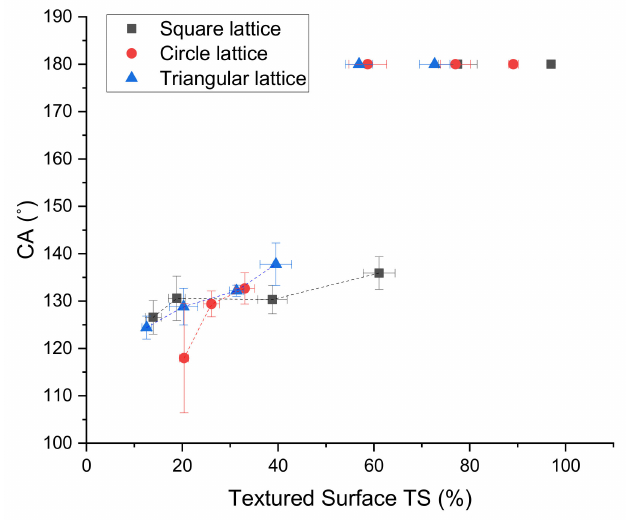
Figure 9. Evolution of the contact angle (CA) as a function of the percentage of the textured surface for the three different textures and a droplet volume of 10 µ